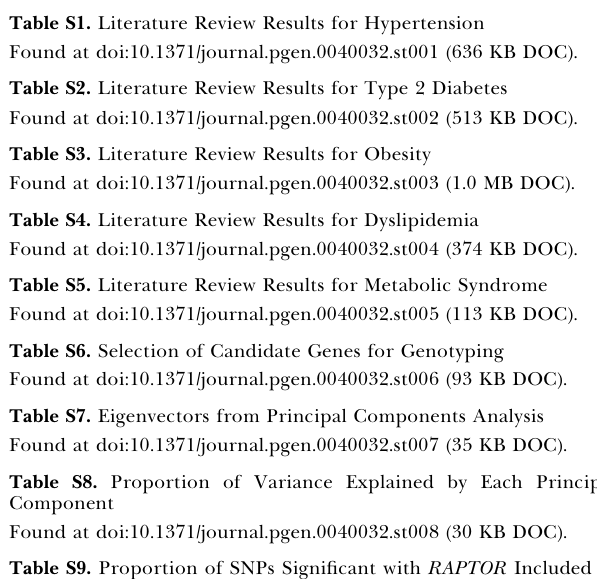
Figure S1. Correlation between Climate Variables and Control SNPs